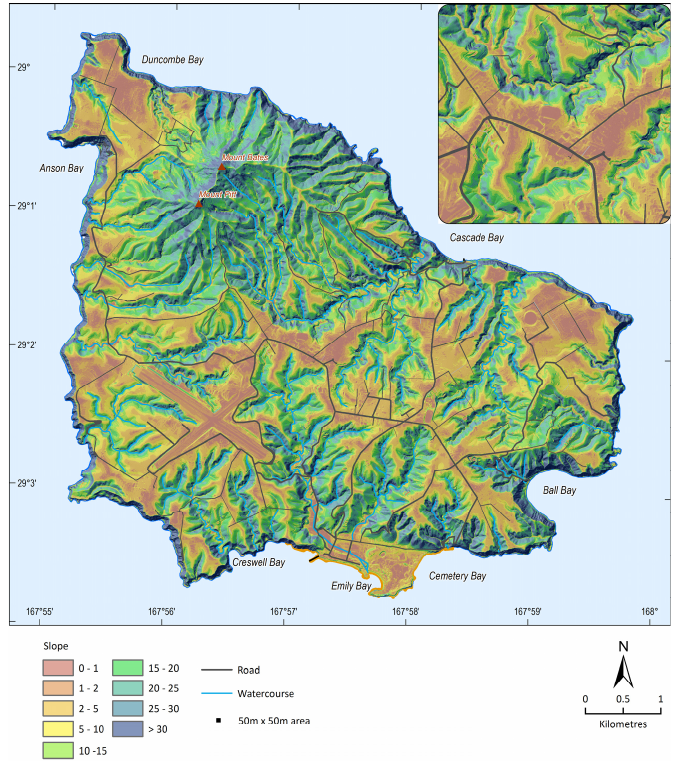
Figure 4. Percentage slope draped over a shaded relief surface of Norfolk Island. Surface derived from LiDAR data.